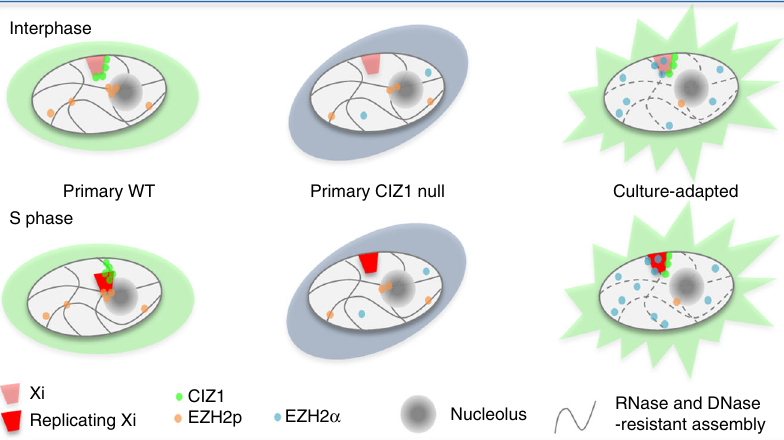
Fig. 8 Summary model. Summary model depicting two alternative pathways by which chromatin and modifying enzymes could meet. Left, anchored and spatially restricted EZH2p (orange) in WT primary cells, and CIZ1-dependent relocation of Xi during replication of Xi. Centre, compromised relocation of Xi in CIZ1 null PEFs and loss of marks from Xi. Right, elevated wild EZH2 α (blue) in culture-adapted cells is depicted diffusing to sites of action. We propose that this compensates for the loss of Xi relocation capability but could lower the stringency with which epigenetic state is maintained in cycling somatic